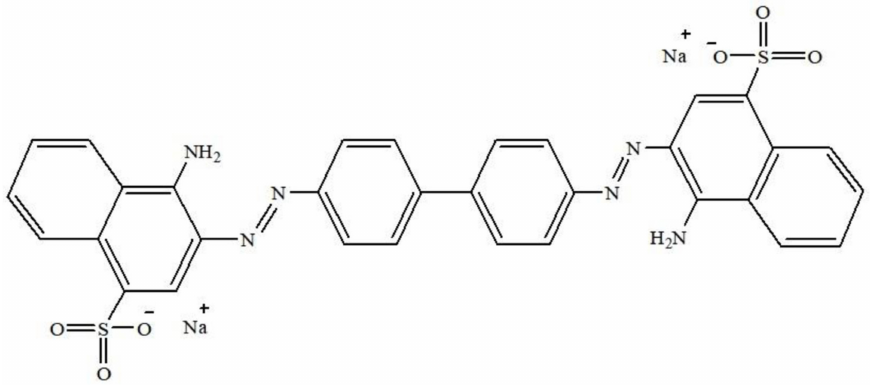
Figure 1. Chemical structure of CR